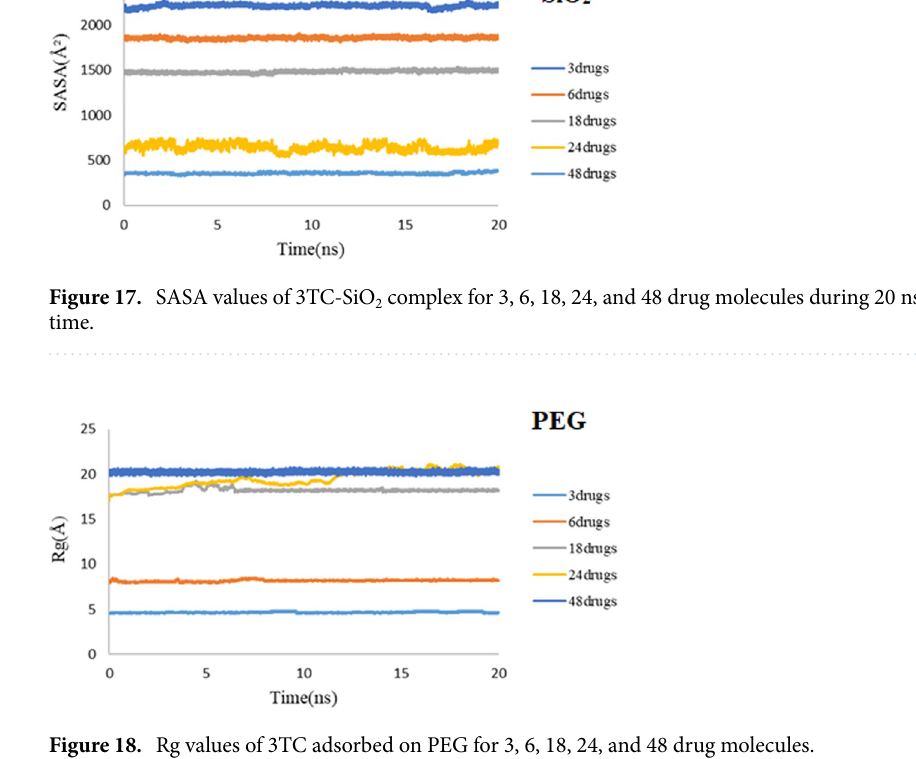
Figure 18. Rg values of 3TC adsorbed on PEG for 3, 6, 18, 24, and 48 drug molecules.